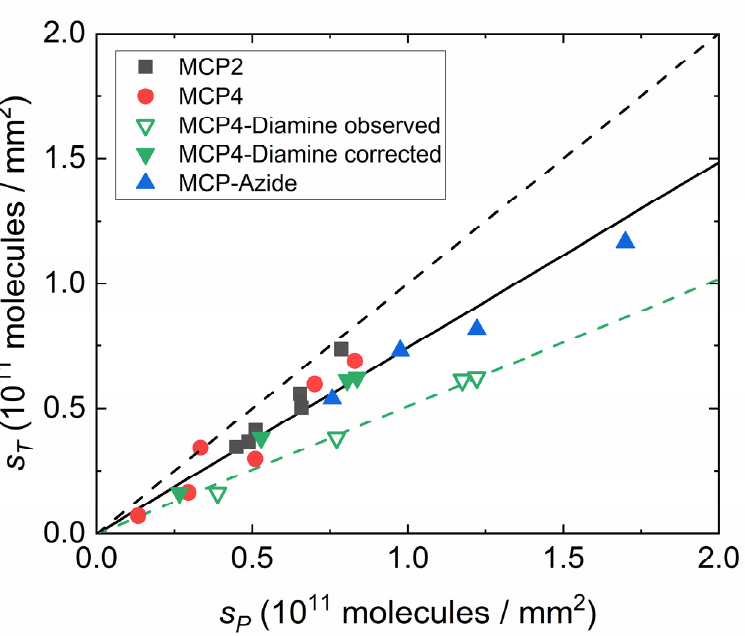
Figure 3. Hybridization yield for different copolymer coatings. The saturation amount of captured target strands per area is plotted as a function of the surface number density of the probe strands. The black continuous line is of a linear fit to the black, red and blue points. The green line displays a linear fit to the green, open points. The dashed line represents S T = S P , i.e., 100% yield.